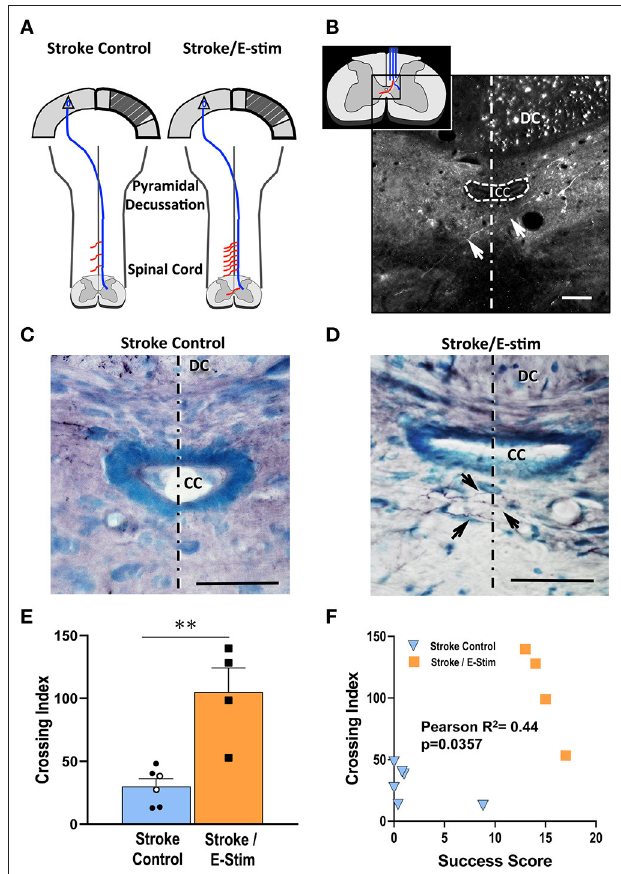
FIGURE 7 | Neuroanatomical analysis. (A) Schematic diagram showing corticospinal plasticity presented as more midline crossing fibers (red lines) along the cervical enlargement after stroke and E-stim treatment. Diagram adapted from Wahl et al. (36). (B) An enlarged schematic midline fiber crossing diagram (inset) and a representative fluorescent photomicrograph shows an alexa fluor 488 streptavidin-labeled BDA-positive midline-crossing corticospinal fiber (arrows) at C6 level. The fluorescent dots in the right dorsal column are BDA-positive corticospinal fibers. (C,D) Photomicrographs of BDA-reacted C6 spinal level sections show differences of corticospinal midline crossing fibers (arrows) between a Stroke Control (C) and Stroke/E-stim animals (D) . (E) Stroke/E-stim treated animals exhibited a significant higher midline crossing corticospinal fiber index in comparison with Stroke control (pooled Stroke Only and Stroke/No E-stim animals) (mean ± SEM, ** p < 0.01, Student’s t -test). Black circles represent Stroke/No E-stim and white circles represent Stroke Only animals. (F) . Midline crossing corticospinal fibers showed positive correlation with the final forelimb reaching success score across 3 groups of animals ( P < 0.05). The dotted lines indicate the midline. The scale bar indicates 50 µ m. DC, dorsal column; CC, central